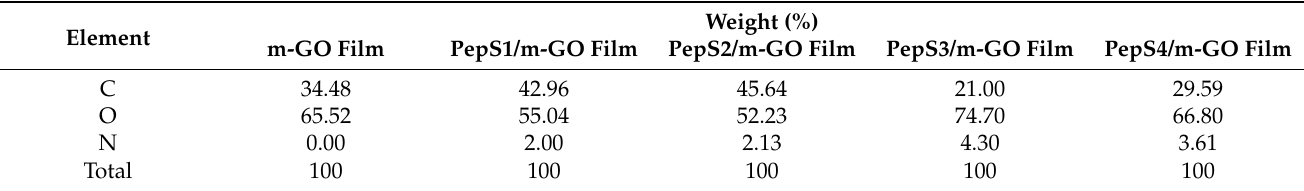
Table 2. Surface composition of the fabricated GO and GO/peptide